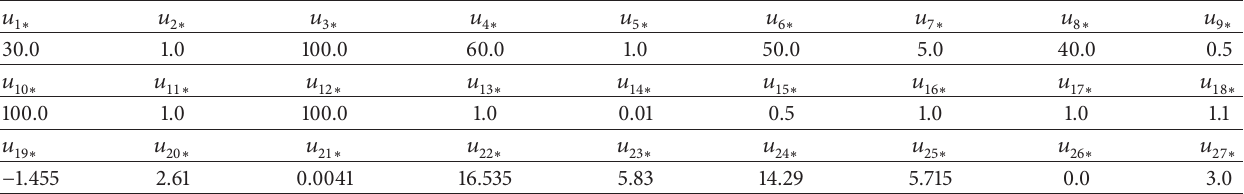
Table 1: The boundary of 𝑢 𝑖∗ [9].